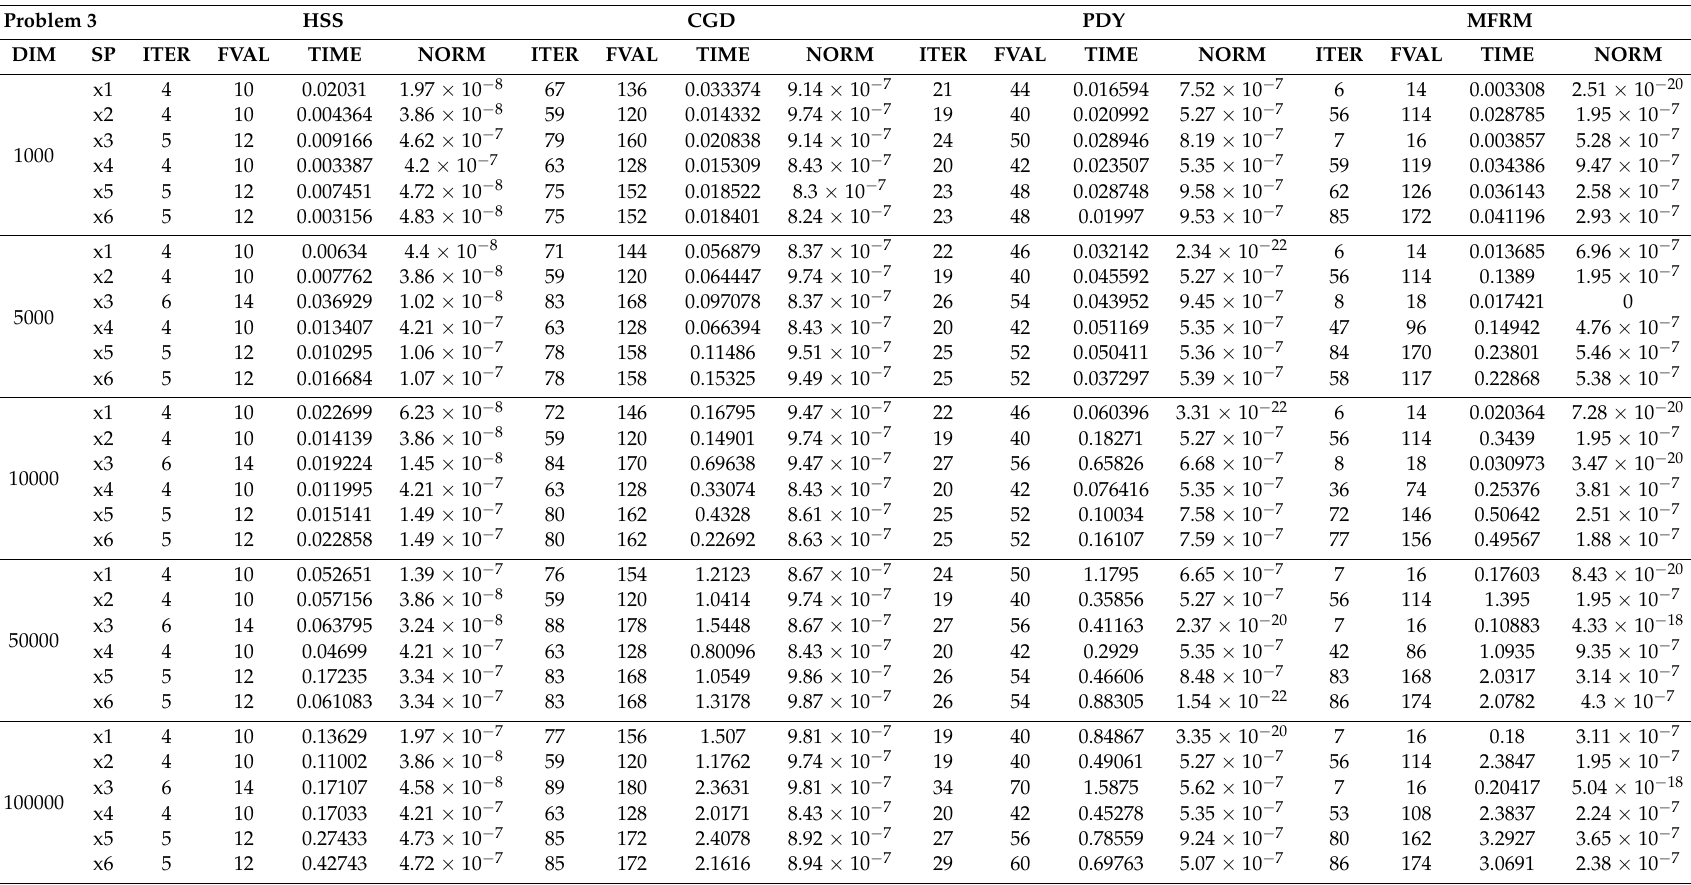
Table 3. Test results obtained by the four solvers for Problem